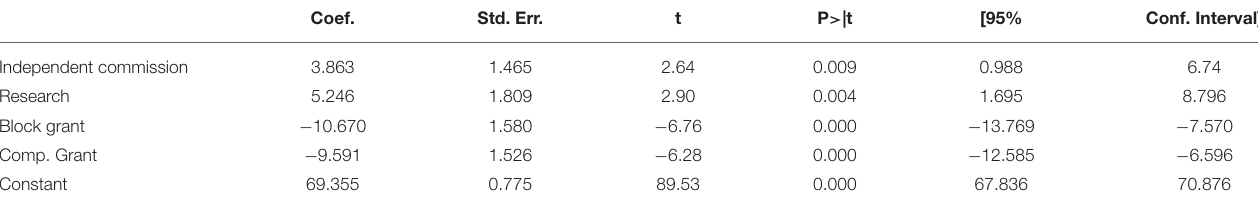
TABLE 6 | PART scores (OLS) by decision maker x commission, model 3. Coef. Std. Err. Conf. Interval]